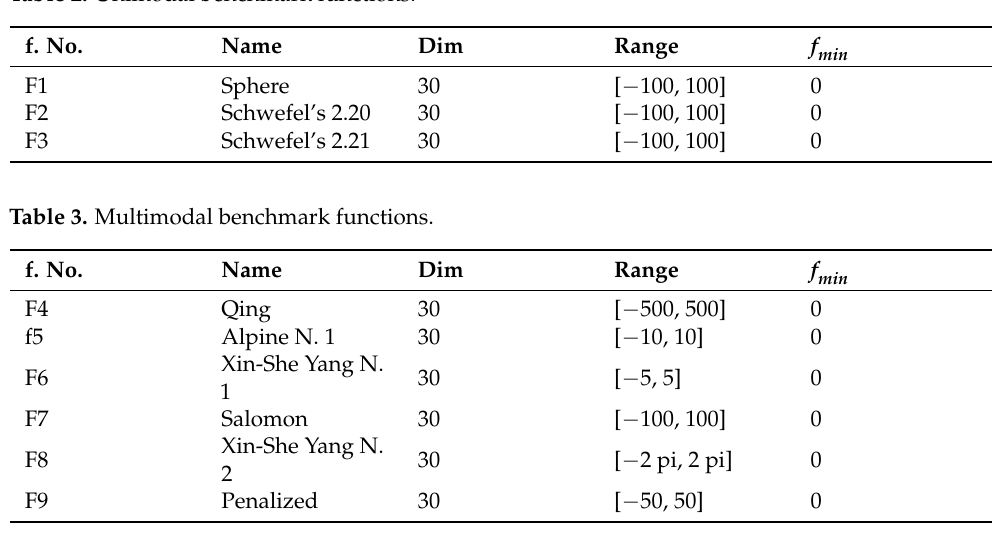
Table 2. Unimodal benchmark functions.